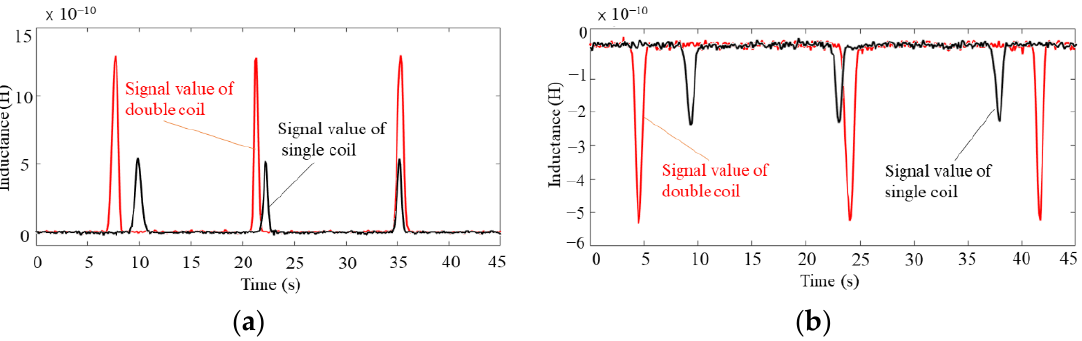
Figure 8. Waveform diagram of metal particle detection with or without permalloy package: ( a ) waveform plots for detecting 80–90 μ m iron particles, ( b ) waveform plots for detecting 140–150 μ m copper particles.